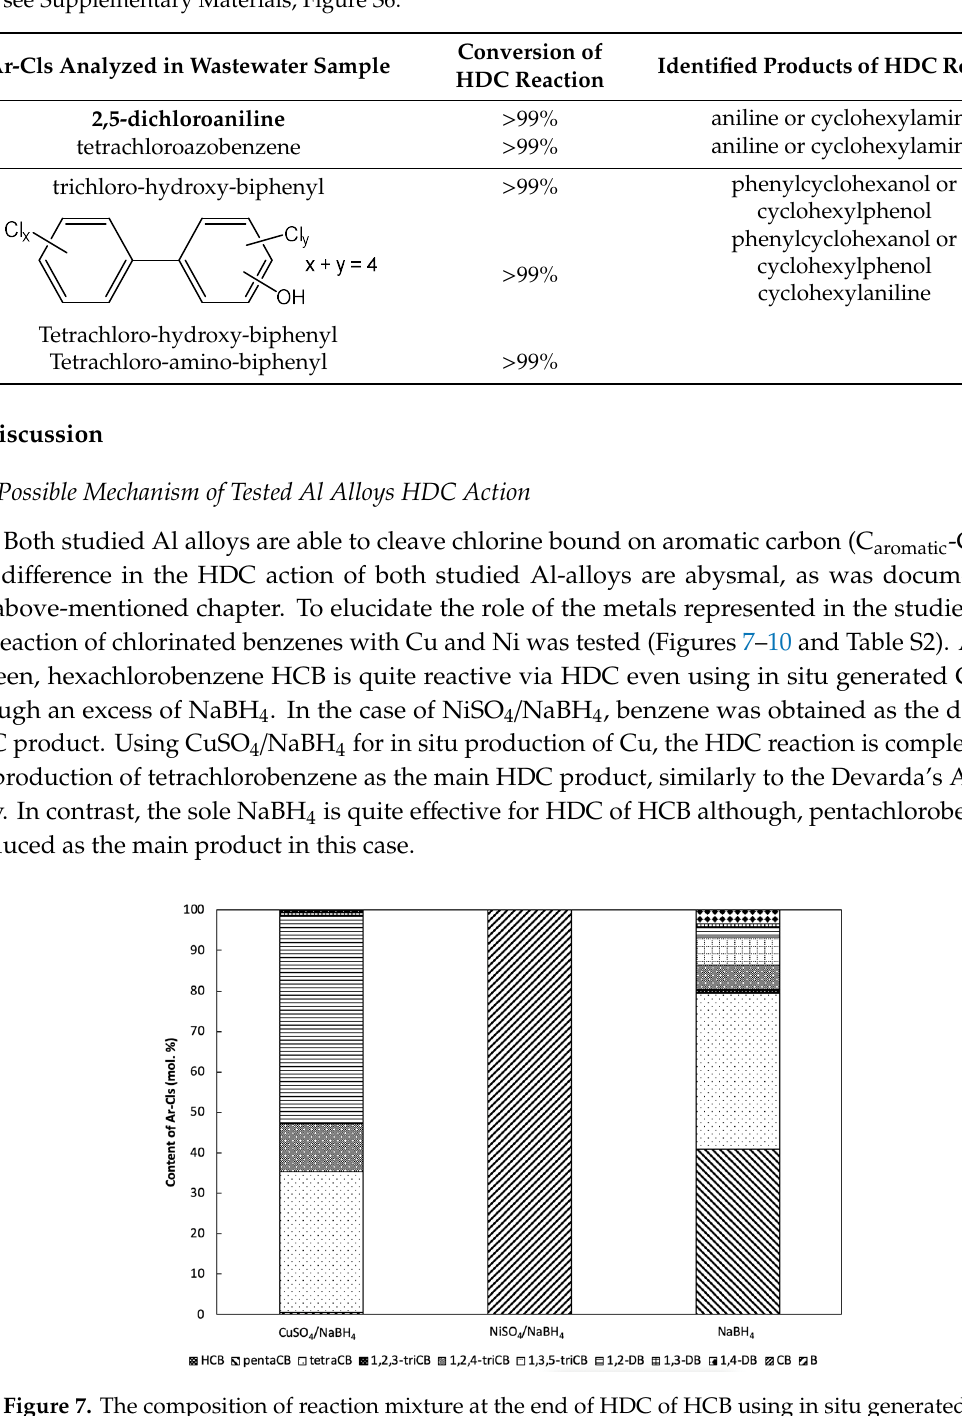
Figure 7. The composition of reaction mixture at the end of HDC of HCB using in situ generated Cu (CuSO 4 /NaBH 4 ), Ni (using NiSO 4 /NaBH 4 ) and comparison of action of the sole NaBH 4 (for more details see Supplementary Materials, Table S2). The experimental details are described in Section 4.2.3.